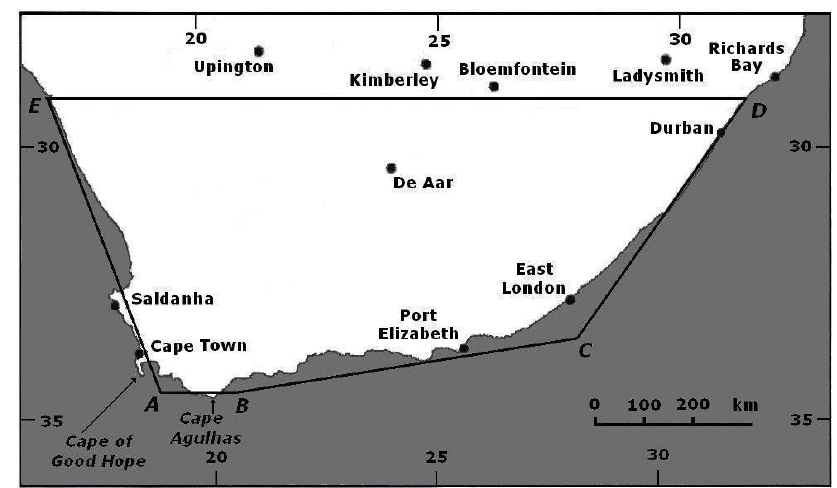
Fig. 2. Map of South Africa with a superimposed pentagon showing the model geometries. ABC corresponds to Concave II (coastline representation for NPR), and BCD corresponds to Concave III (SIF). Concave I is a zonal south-facing coastline contiguous with a slanted eastern shore (that could be NPR or SIF represented by different angles of slant or a mean slant).